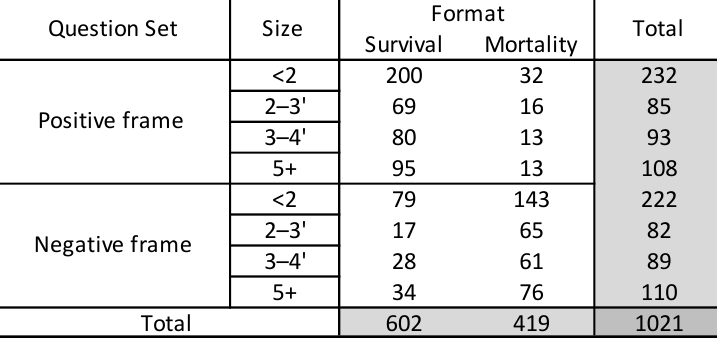
Figure 10. Respondent total by household size.